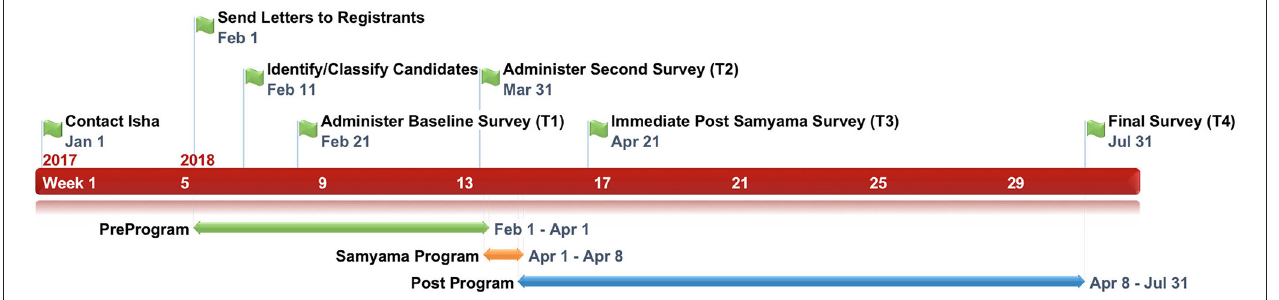
FIGURE 1 | Samyama retreat